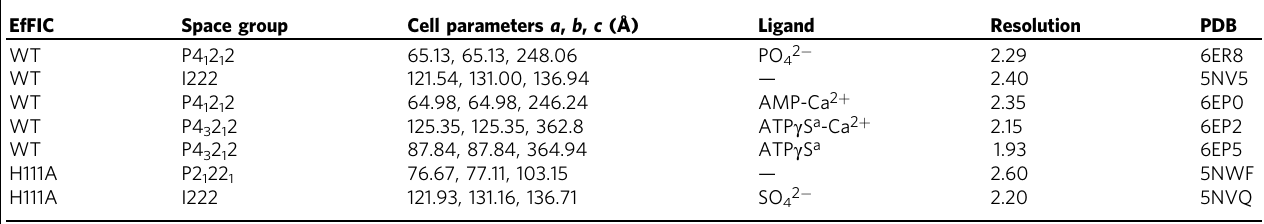
Table 1 Summary of the crystal structures of EfFIC determined in this